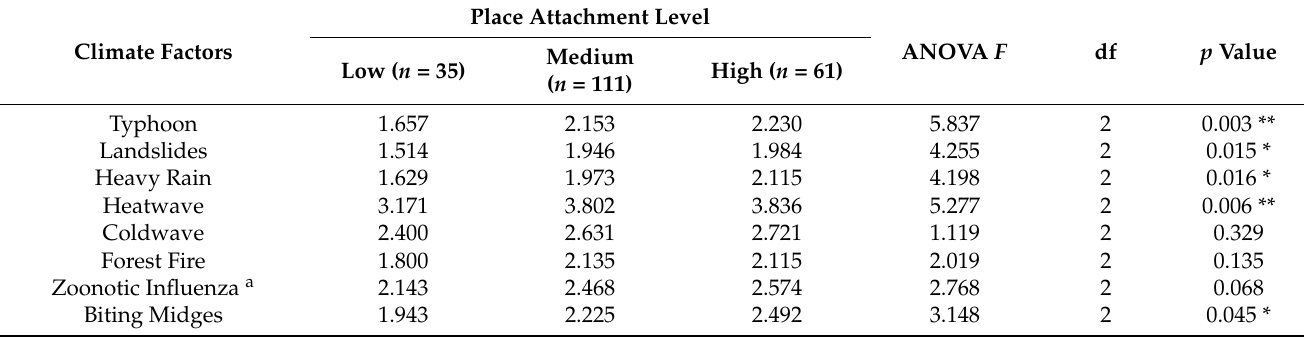
Table 11. Tourists’ travel intention under pre-adaptational policy conditions based on place-attachment score clusters and climate factors. Place Attachment